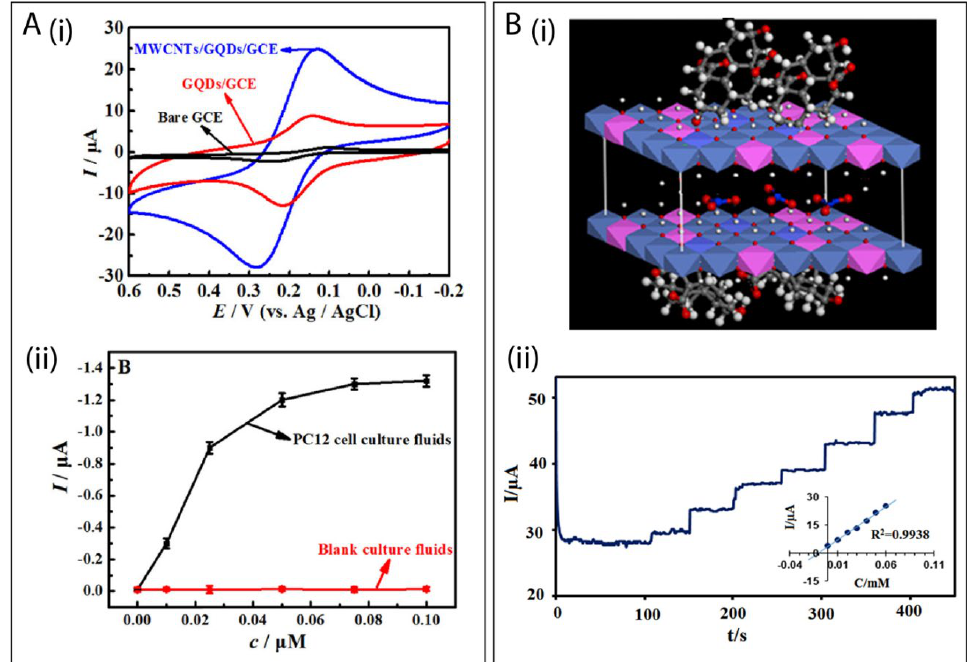
Figure 6. ( A ) ( i ) Cyclic voltammograms of GCE, GQDs/GCE, and MWCNTs/GQDs/GCE in 0.1 mM DA (scan rate of 0.1 V s − 1 ) and ( ii ) the anodic peak current (I pa ) of DA in the PC12 cells